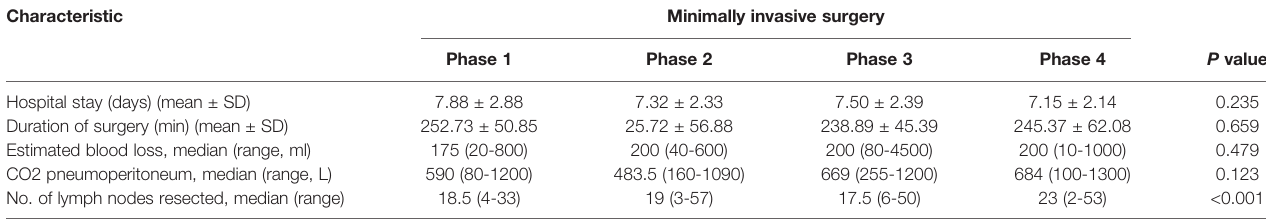
SD, standard deviation.